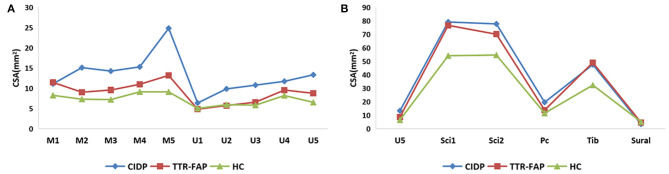
A general view of mean CSAs at sites of upper limbs (A) and lower limbs (B) between the three groups. (A) Clearly presented the CSAs in upper limbs, and revealed most CSAs of TTR-FAP groups at bilateral median nerves were higher than those of HC groups but lower than those of CIDP groups. (B) Showed most CSAs of TTR-FAP groups were between those of CIDP and HC groups in lower limbs.